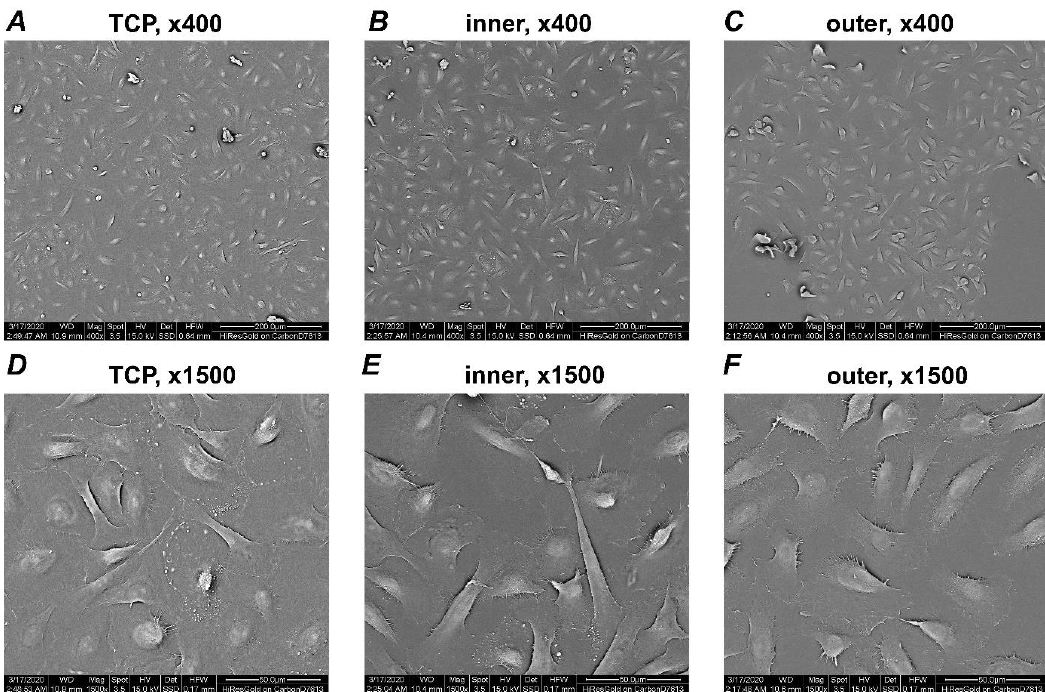
Figure 1. Scanning electron microscopy analysis of HOKs. HOKs were grown on two different aligner surfaces. Pictures were taken at two different magnifications (upper row, 400×; lower row, 1500×). Cells were seeded on TCP as control ( A , D ), inner ( B , E ) and outer ( C , F ) aligner surfaces. Pictures were taken after 2 days of culture. Scale bars correspond to 200 µm ( A – C ) or 50 µm ( D – F ).